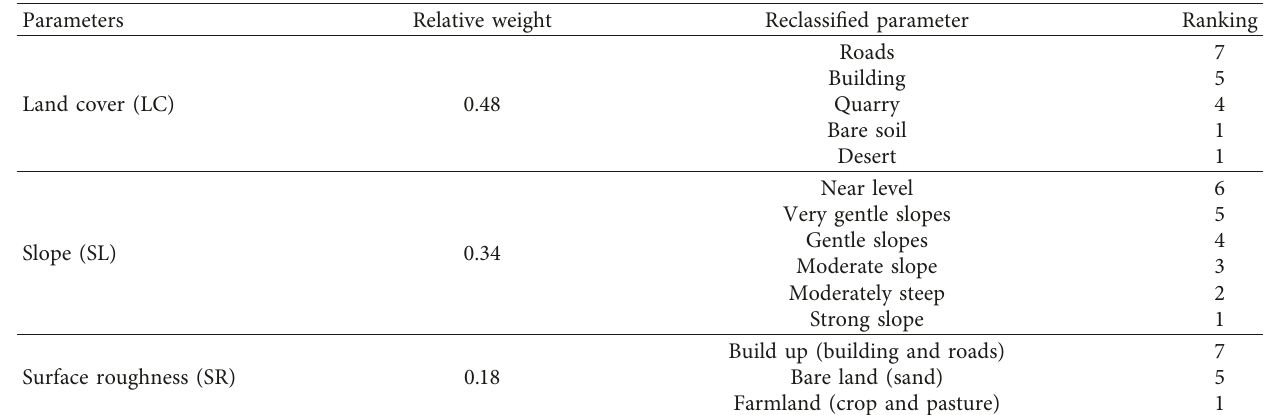
Table 5: The rating of the three